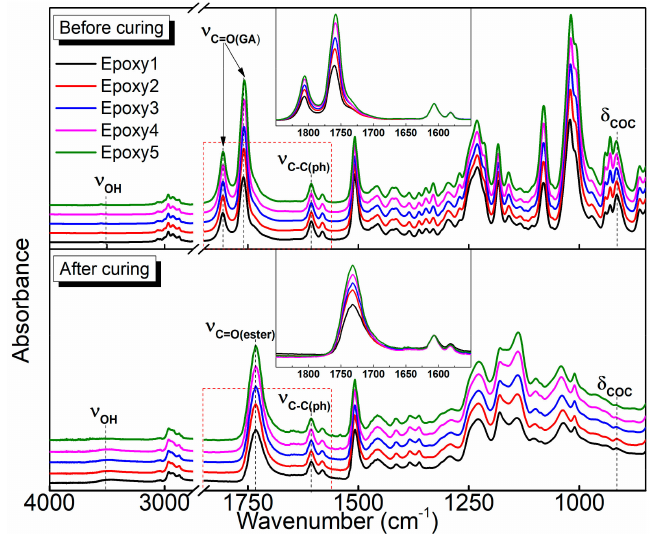
Figure 4. Fourier Transform Infrared Spectroscopy (FTIR) spectra of five epoxy systems with different contents of GA before and after curing. The curing condition is 100 ◦ C for 2 h and then 150 ◦ C for 6